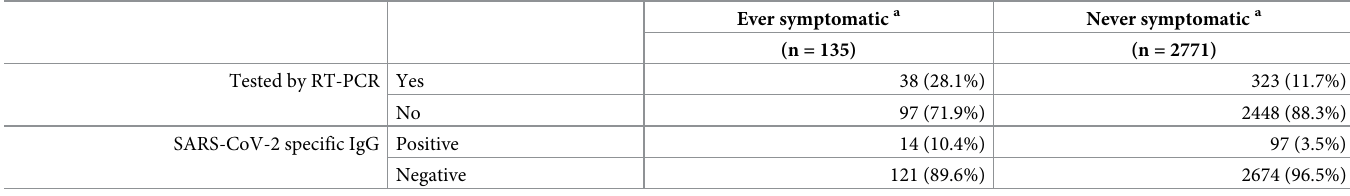
Table 2. Status of RT-PCR testing and seropositivity by COVID-19 compatible symptoms. Ever symptomatic a Never symptomatic a (n = 135) (n = 2771) Tested by RT-PCR Yes 38 (28.1%) 323 (11.7%) No 97 (71.9%) 2448 (88.3%) SARS-CoV-2 specific IgG Positive 2674